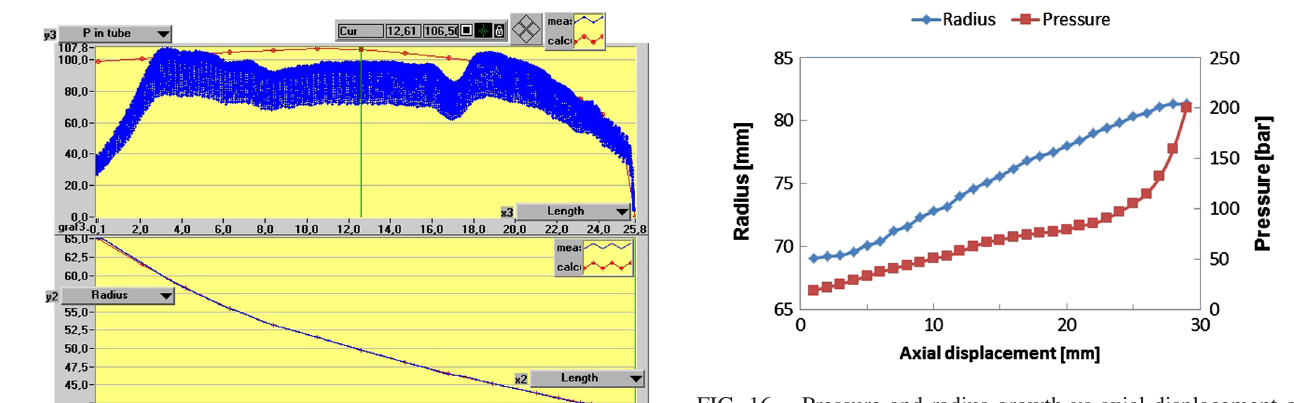
constraint.FIG. 16. Pressure and radius growth vs axial displacement on the first stage of the